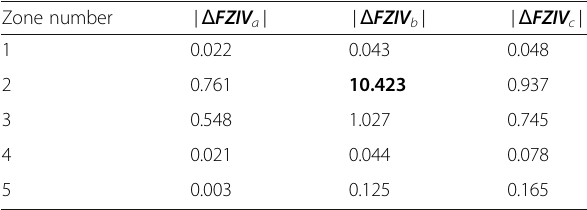
Table 1 FZIV Preceding the fault Zone